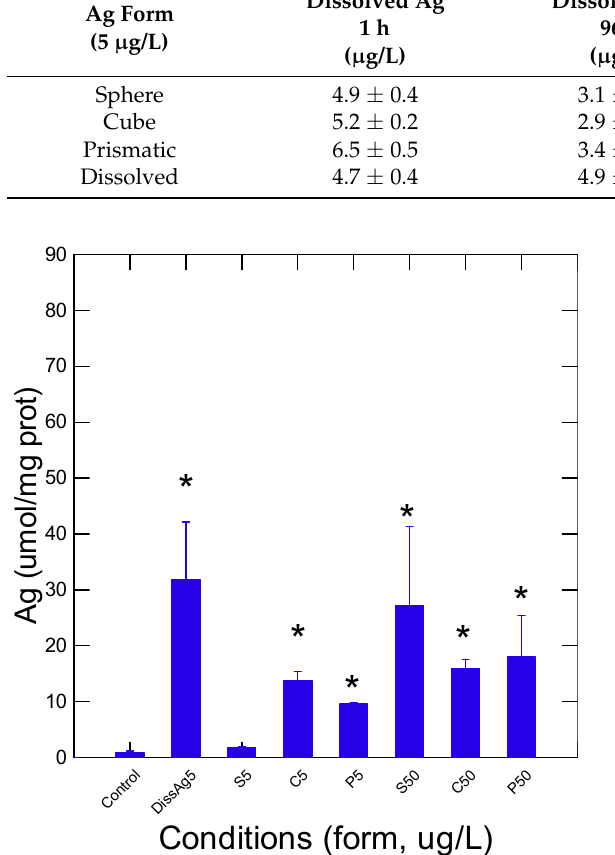
Figure 1. Relative Ag levels in fish gills. The relative levels of Ag were determined by an enhanced luminol/Na 2 CO 3 chemiluminescence in gill homogenates. The data represent the mean with standard error. Abbreviations for x-axis (and for the following figures): DissAg5 (5 µ g/L of dissolved Ag), S5 (spherical nAg; 5 µ g/L), C5 (cubic nAg; 5 µ g/L), P5 (prismatic nAg; 5 µ g/L), S50 (spherical; nAg, 50 µ g/L). The star * symbol indicates significance at p ≤ 0.05 from controls. Table 2. Change in fish morphology following exposure to the various forms of Ag.